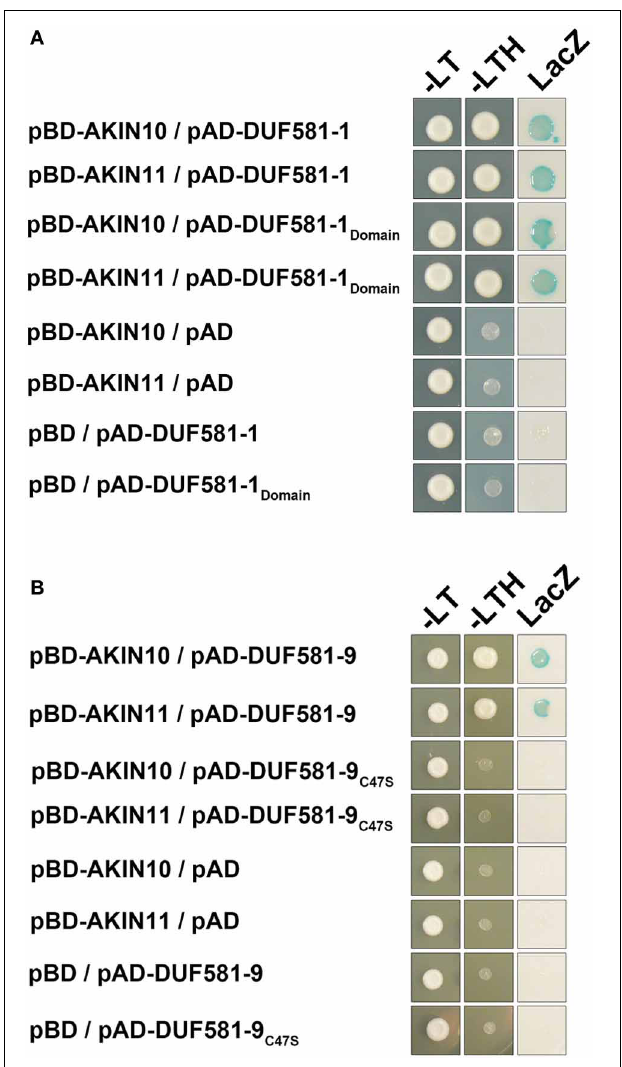
FIGURE 4 | DUF581 is necessary and sufficient to mediate SnRK1 binding in yeast. Cells were grown on selective media for 3 days at 30 ◦ C before the pictures were taken. Empty BD and AD vectors served as control. –LT, yeast growth on medium without Leu and Trp. –HLT, yeast growth on medium lacking His, Leu, and Trp, indicating expression of the HIS3 reporter gene. LacZ, activity of the lacZ reporter gene. (A) AKIN10 or AKIN11 fused to the GAL4 DNA-binding domain (BD) were expressed in combination with truncation construct of DUF581-1 comprising the DUF581 (amino acids 138–192) fused to the GAL4 activation domain (AD) in yeast strain Y190. (B) AKIN10 or AKIN11 fused to the GAL4 DNA-binding domain (BD) were expressed in combination with pAD-DUF581-9C47S, carrying a cysteine to serine exchange within the DUF581.